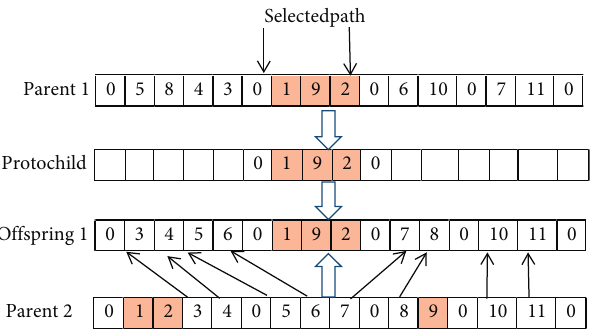
Figure 6: The process of crossover operation.